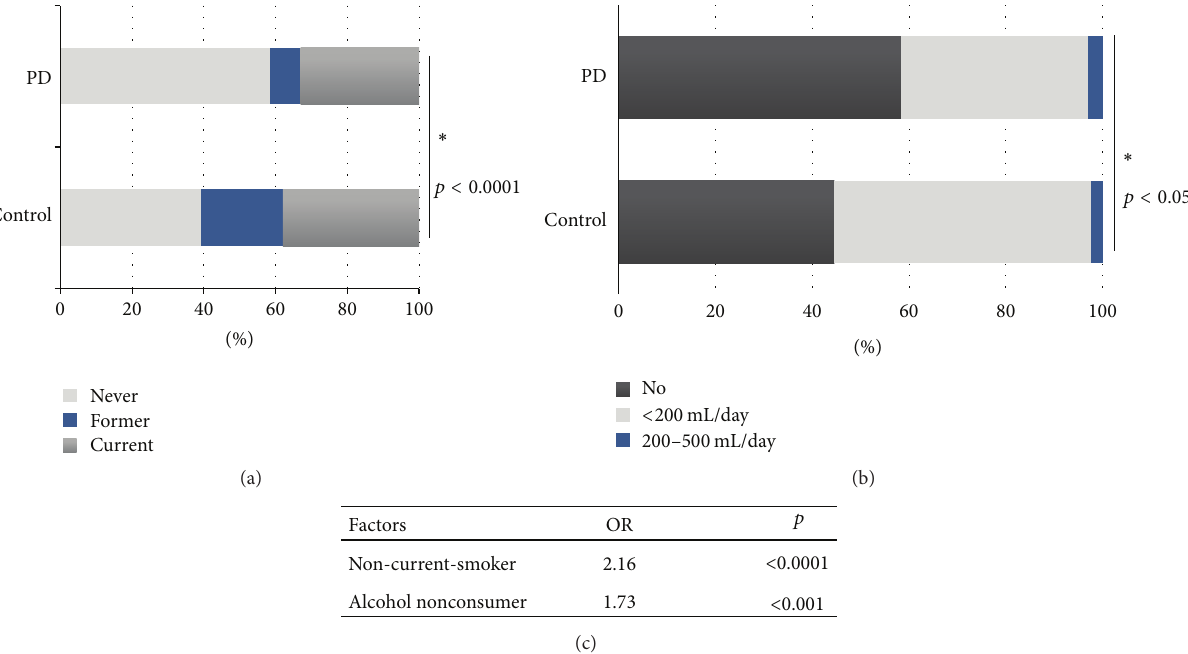
Figure 3: (a) Smoking status in the two groups. (b) Alcohol consumption in the two groups. (c) OR of non-current-smokers and alcohol nonconsumer. ∗ means statistical